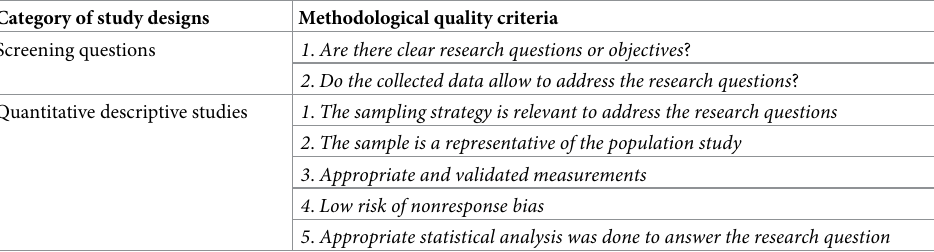
Table 1. Mixed Methods Appraisal Tool (MMAT), version 2018 indicators for screening questions and quantita- tive descriptive studies (adapted from Hong et al .